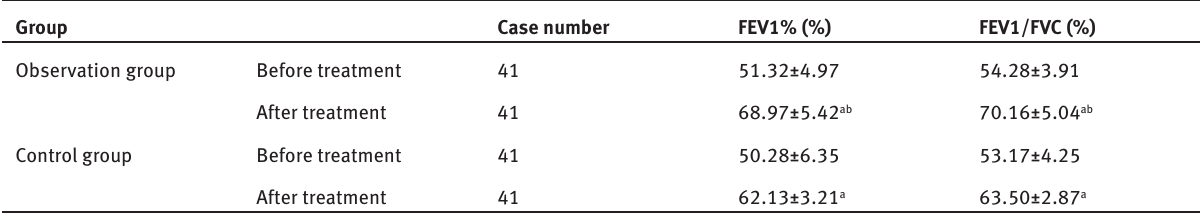
Table 8: Comparison of pulmonary functions between two groups before and after treatment ( ±s)